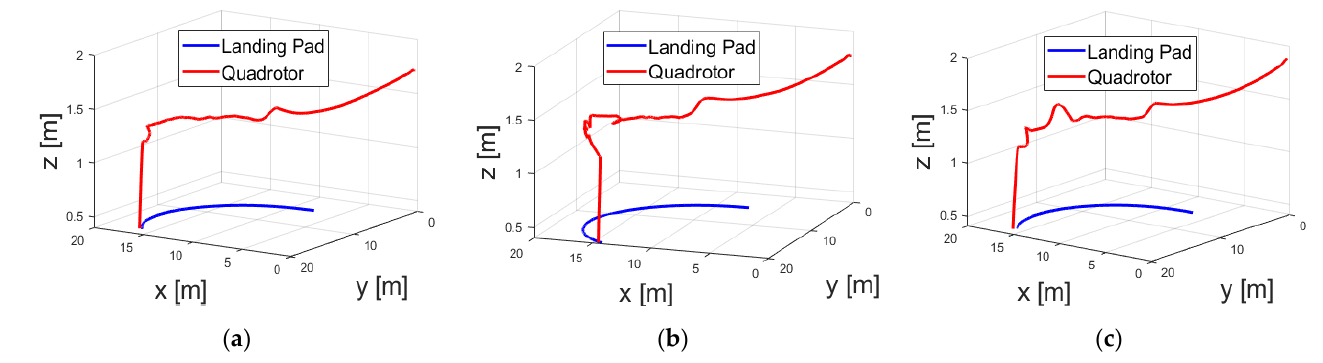
Figure 13. Trajectory of quadrotor in the wind field. ( a ) Trajectory with a mean wind velocity of 4 m/s and maximum wind velocity of 7 m/s. ( b ) Trajectory with a mean wind velocity of 7 m/s and maximum wind velocity of 11 m/s. ( c ) Trajectory with a mean wind velocity of 11 m/s and maximum wind velocity of 15 m/s. Table 1. Average position error in x direction and y direction within 5 s before landing.